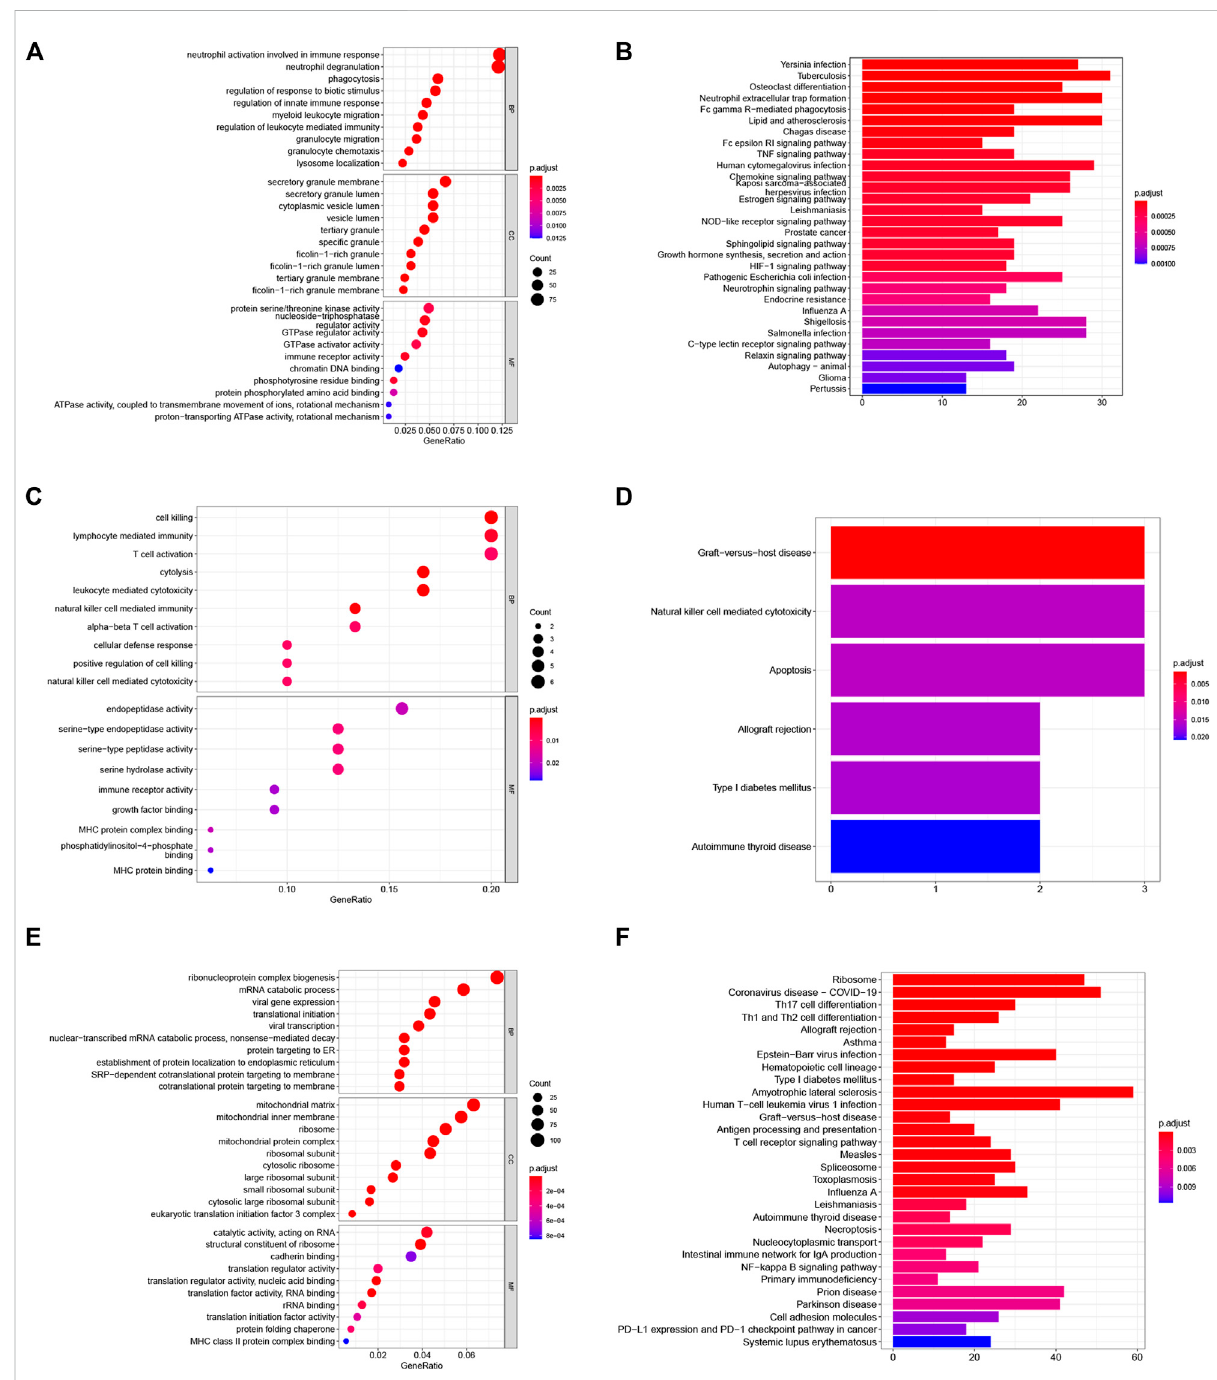
FIGURE 3 FunctionalenrichmentanalysisoftheaSAH-relatedmodule. (A,B) TheGOandKEGGanalysisofthegenesinthebluemodule. (C,D) TheGOand KEGG analysis of the genes in the tan module. (E,F) The GO and KEGG analysis of the genes in the turquoise